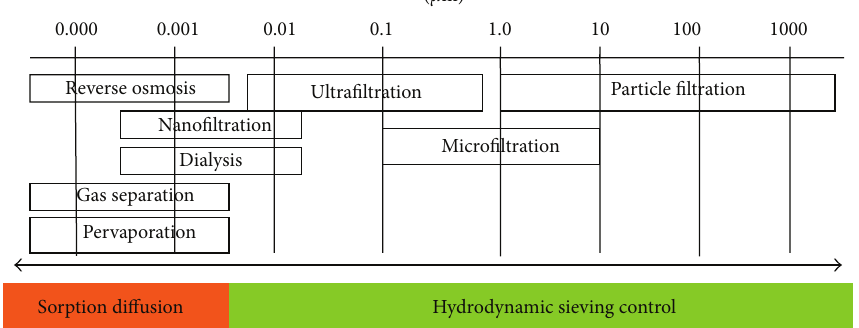
Figure 1: The choice of membrane with respect to the size of particles